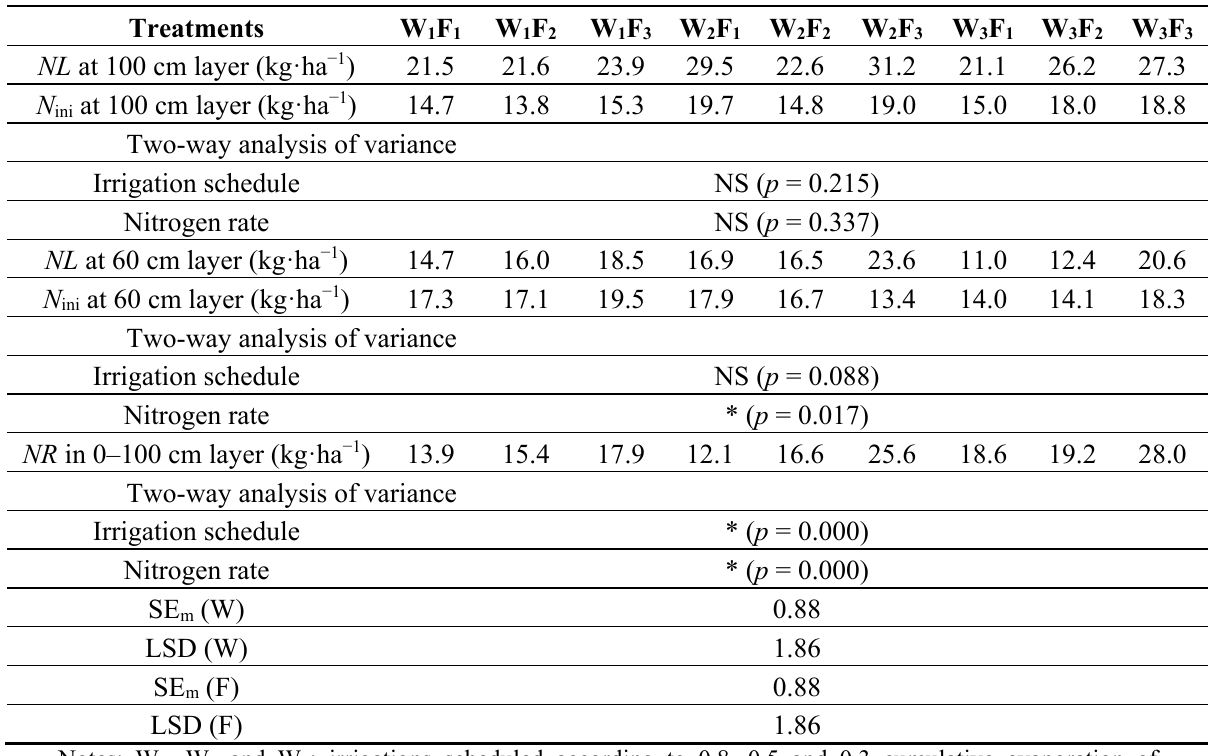
Table 6. Nitrate leaching ( NL ), initial nitrate concentration ( N ini ) and nitrogen residual ( NR ) for all treatments during the wheat season of